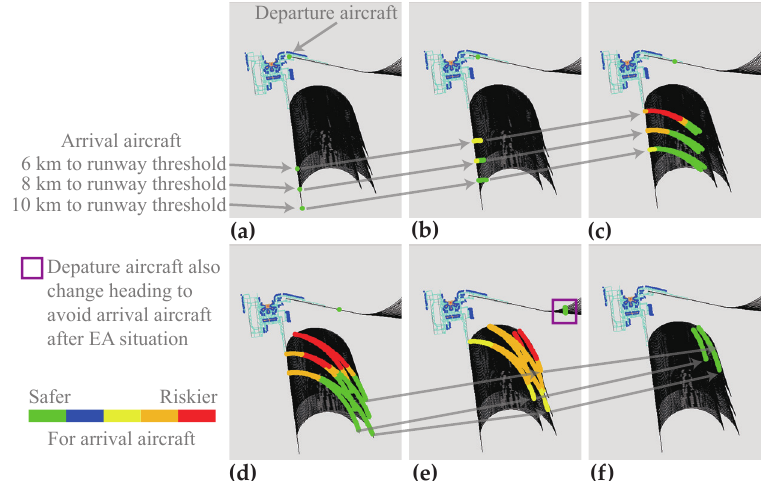
Figure 12. Schematic diagram of the northward operation of PKX under EA situation (the ADW separations were 0 km to 6/8/10 km respectively, and the aircraft type was A320). The screenshots in subgraphs ( a – f ) illustrate the progression of simulation time. The gray arrows represent the relationship between arrival aircraft at various distances in successive simulation time frames. In the simulation process, EA situations might occur in every time frame for every arrival aircraft. Consequently, each sub-graph represents the EA situation of every arrival aircraft at a particular time.